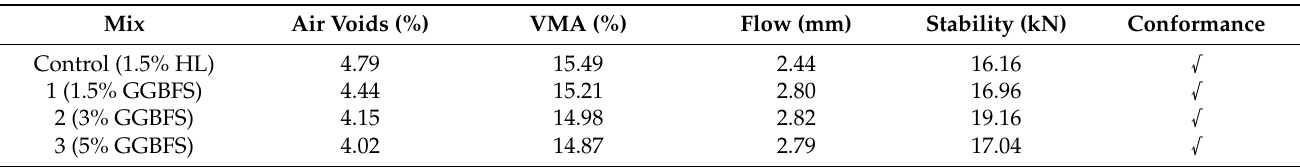
Table 8. Marshall properties of the asphalt